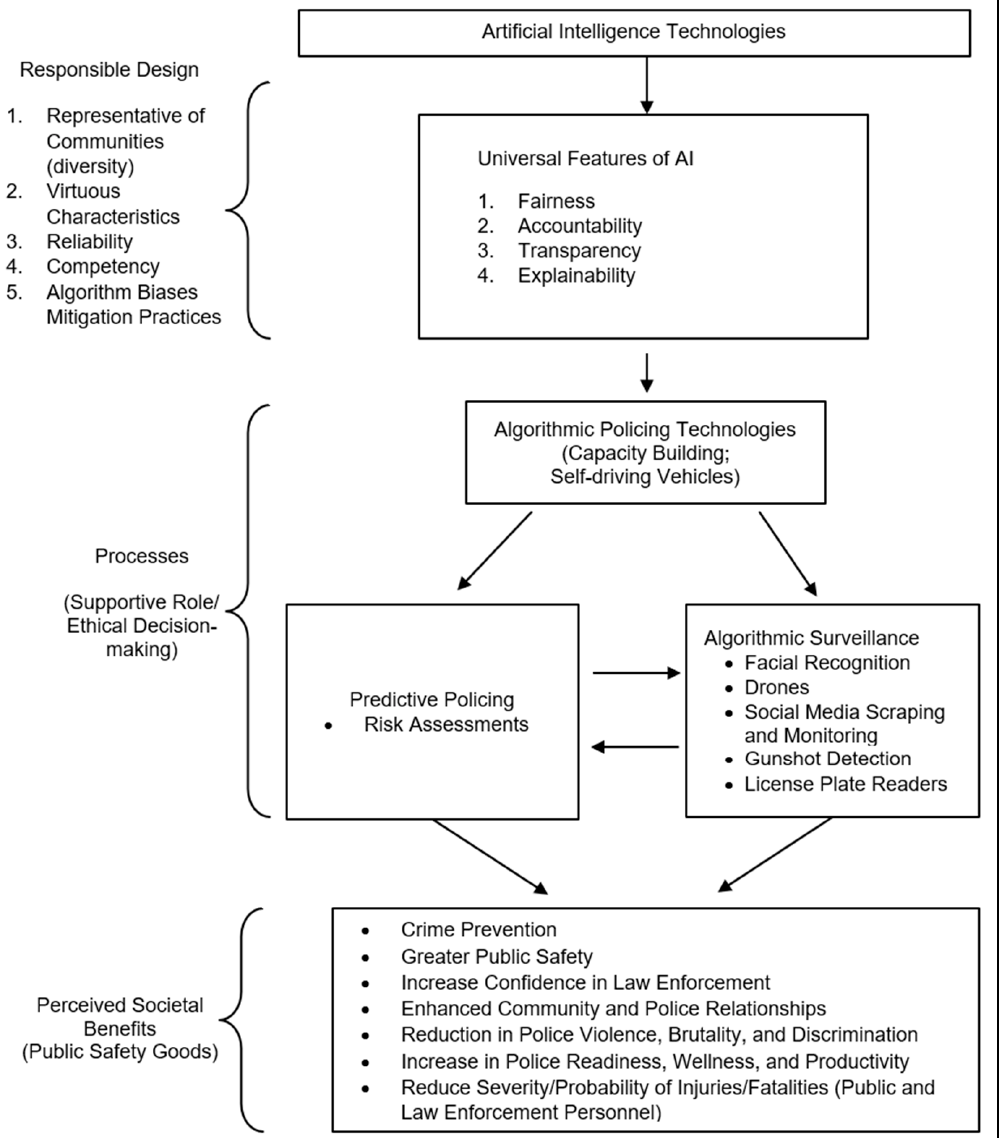
Figure 5. Addressing ethical and societal concerns by responsible design in AI policing technologies.